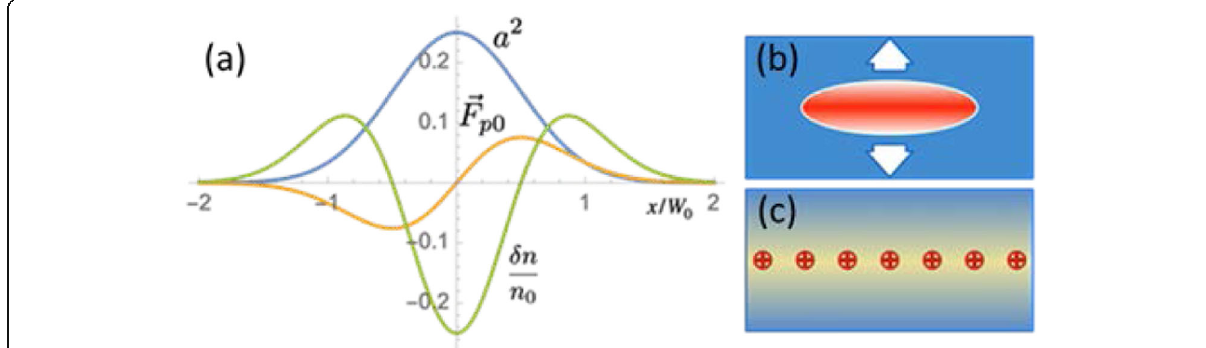
Fig. 9 Plasma channel formation due to the ponderomotive force of a laser pulse. a The transverse laser profile (square of the normalized vector potential, blue), the corresponding ponderomotive force (orange), and the electron density (green) as a function of x / W 0 . b A cartoon of the laser pulse with the direction of the ponderomotive force marked by arrows. c The resulting channel formed due to immobile